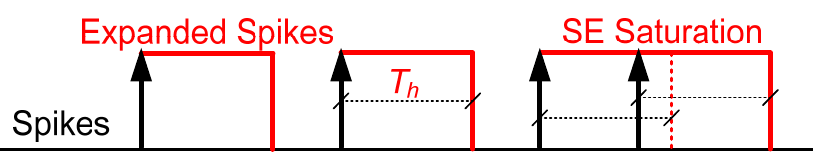
Figure 3. Expanding spikes in order to drive a DC motor.